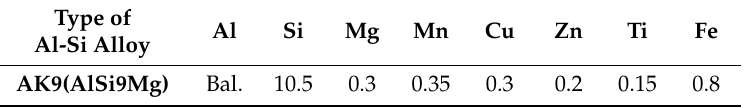
Table 1. Chemical composition of AlSi9Mg, wt.%.